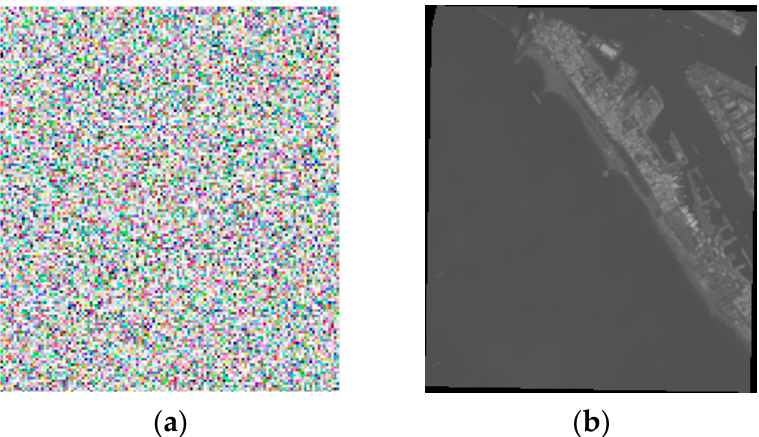
Figure 7. Landsat spectral images: ( a ) Multispectral band; ( b ) Panchromatic sharpening band. The final step is to process the multispectral images to obtain RGB images. To improve the efficiency and accuracy of sea–land segmentation, the methods use panchromatic image sharpening and downsampling to enhance the resolution and obtain better coastline- detection performance; and cloud masking to reduce the misjudgment of white foam during subsequent classification. Figure 8a is the pre-processed color satellite image of the Kaohsiung port, and Figure 8b is an image of the Kaohsiung port covered by clouds and fog.